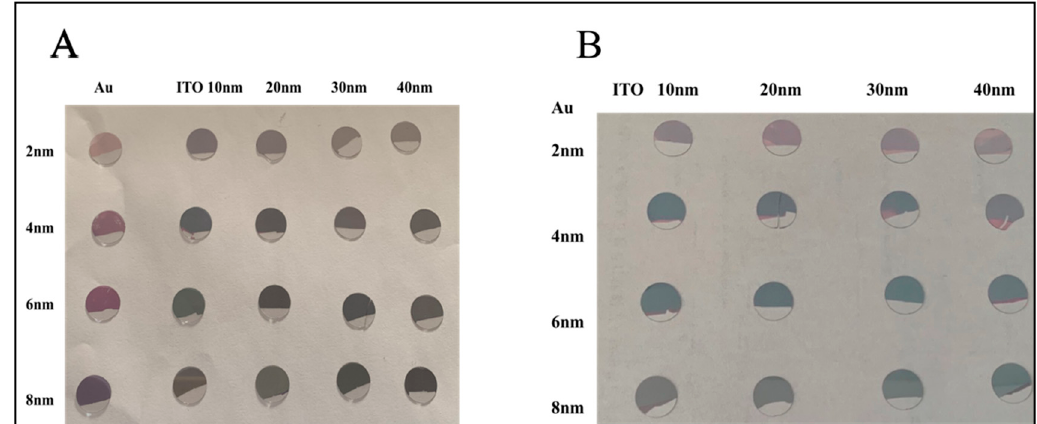
Figure 2. Round glass coverslips coated with Au and ITO-Au thin films and exposed for 3 h at 550 °C. ( A ) One-step annealing protocol and ( B ) Two-step annealing protocol .